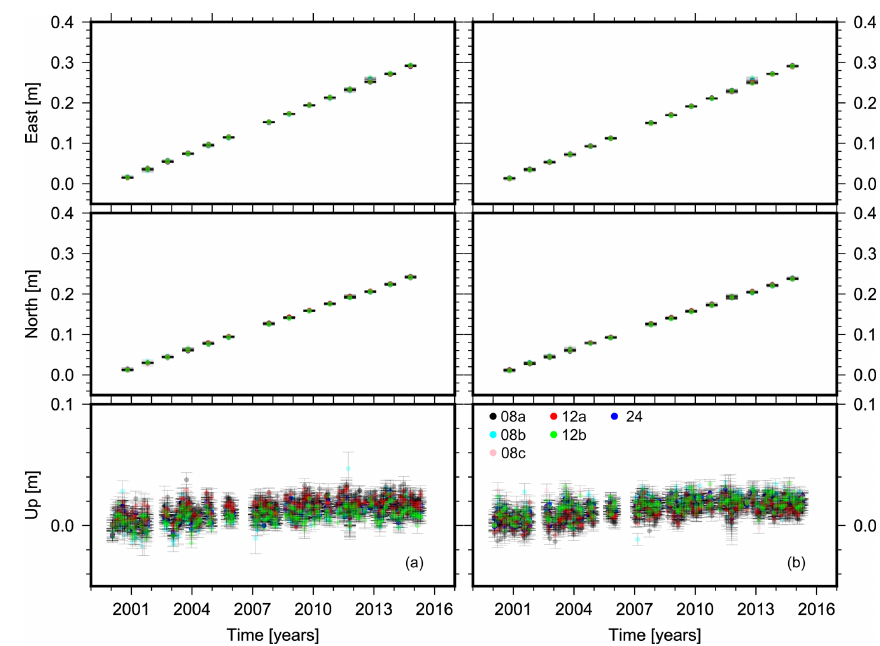
Figure 3. Time series of all sub-sessions for the site ZIMM from (a) relative positioning and (b) PPP solutions.